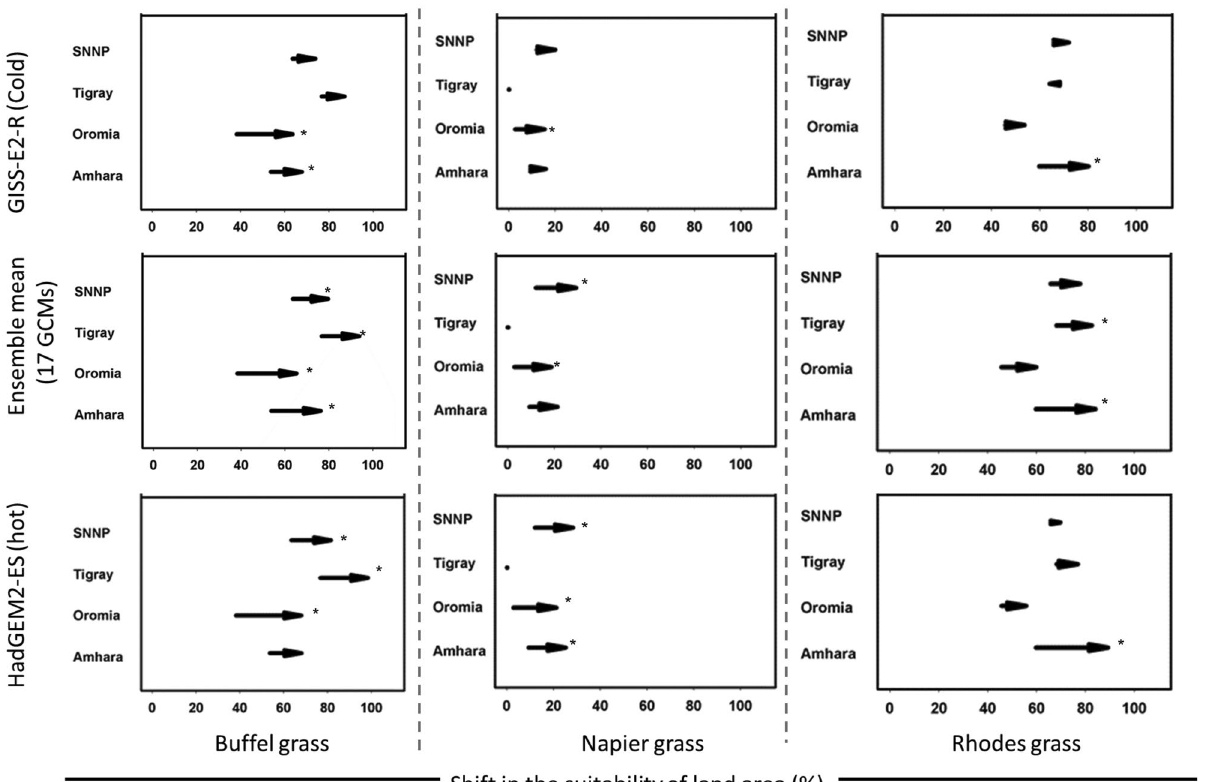
Figure 2. Prediction shifts in areas suitable for the cultivation of Buffel, Napier and Rhodes grasses in regions of Ethiopia. The arrows indicate the shift in land area as a % of the land area of each region from current (1970–2000) conditions to those predicted under different climate change scenarios (left-hand axis), based on predicted impacts on temperature, rainfall and growing season. *Indicates significant change p < 0.05, with Power of analysis =